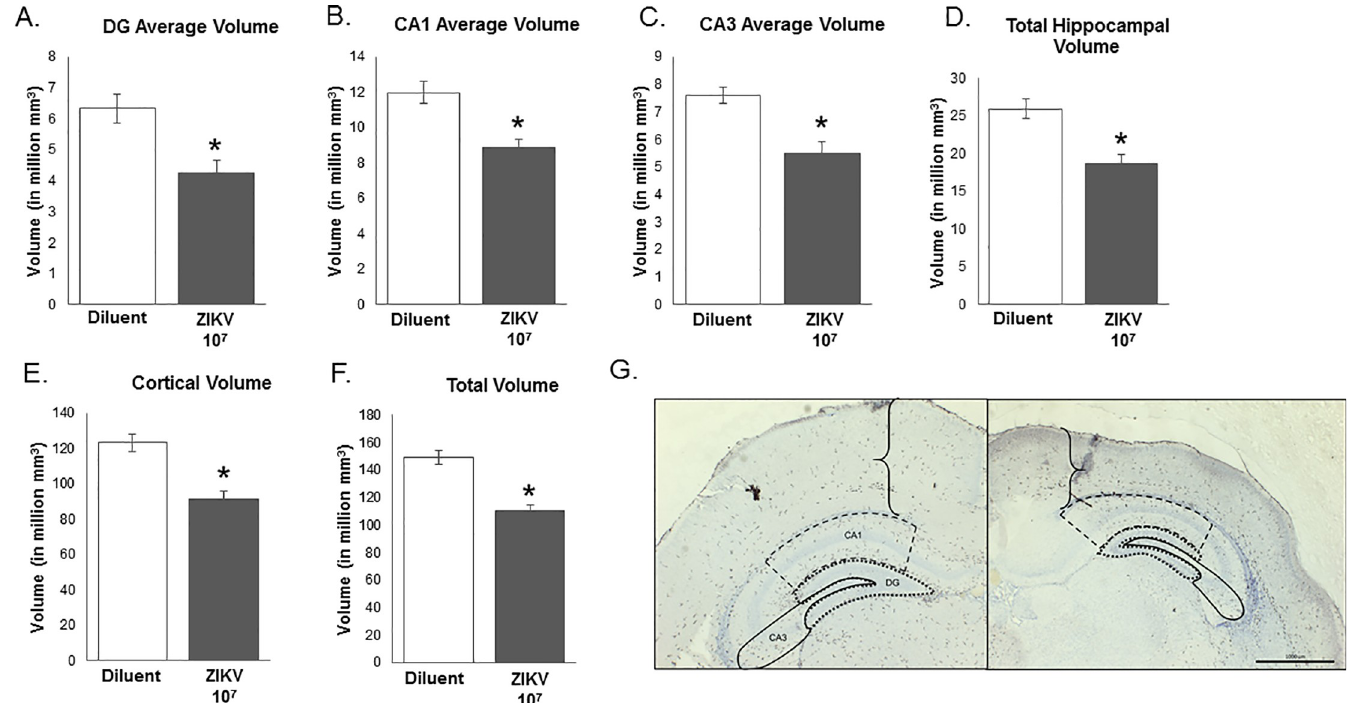
Fig 2. Analysis of hippocampal and cortical brain region volume in postnatal day 2 pups born of moms treated with ZIKV 10 7 or diluent control. There was a significant effect of ZIKV infection on the volume of all brain regions examined ( A , DG: F 1,10 = 11.558, P = 0.007; B , CA1: F 1,10 = 16.161, P = 0.002; C , CA3: F 1,10 = 15.350, P = 0.003; D , Cortex: F 1,10 = 22.282, P = 0.001; E , whole hippocampus: F 1,10 = 16.380, P = 0.002; F , total volume: F 1,10 = 33.137, P < 0.001), where brain volumes were significantly smaller in the pups infected with ZIKV compared to the uninfected controls. ( G ) Representative images of diluent and ZIKV pup cortex thickness and hippocampus size. n = 6 animals per group. � : p <